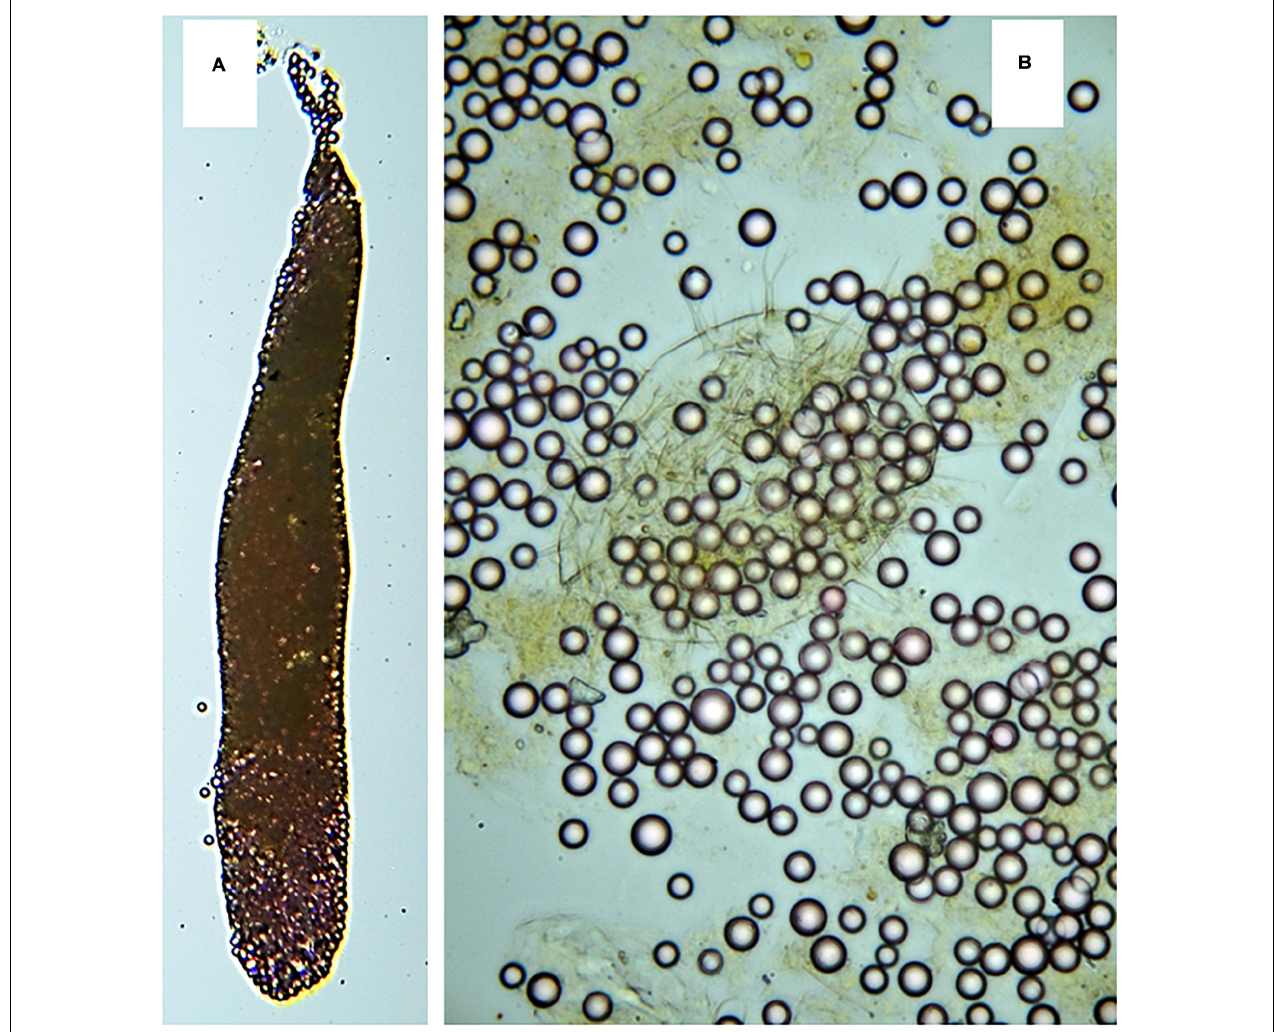
FIGURE 1 | (A) Photograph of an intact fecal pellet–450 µ m length and crushed (B) to count plastic beads of sizes 6 and 12 µ